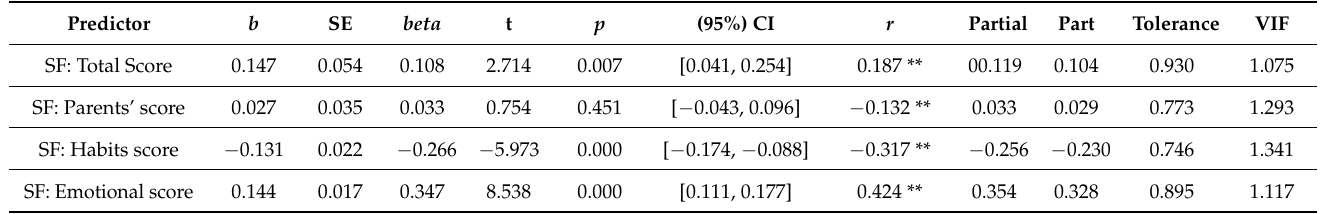
Table 4. Linear regression results for the effect of socio-familial behavior under social isolation during the COVID-19 pandemic dimensions on sleep quality.